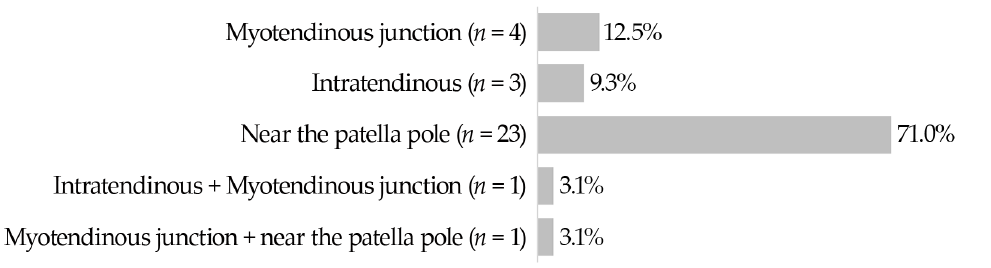
Figure 2. Rupture site based on MRI evaluation.